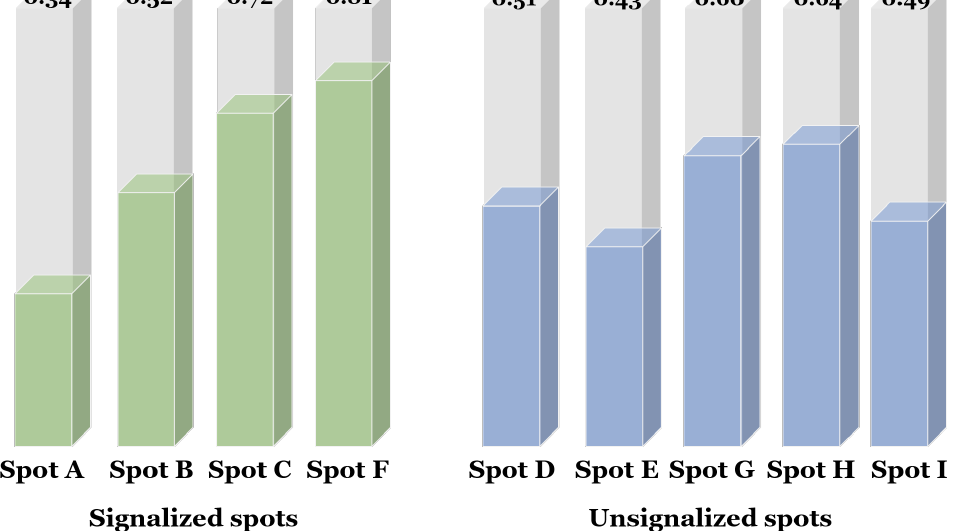
Figure 16. The percentages of drivers stopping within 10 m from crosswalks for scenes with pedestrians on crosswalks.